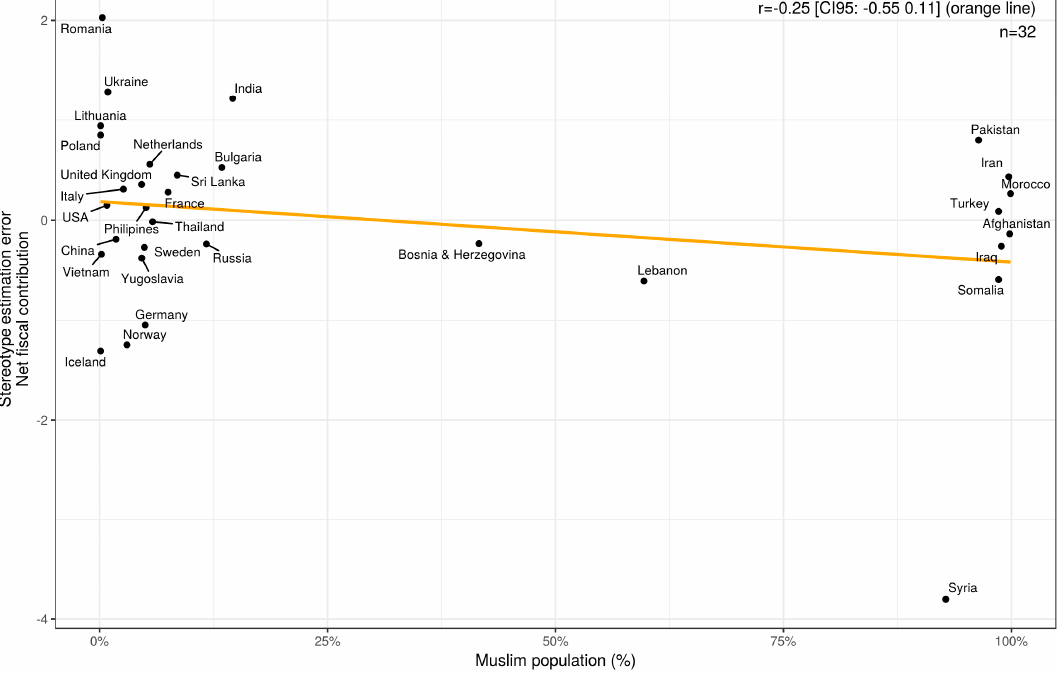
Figure 2. Muslim bias in aggregate